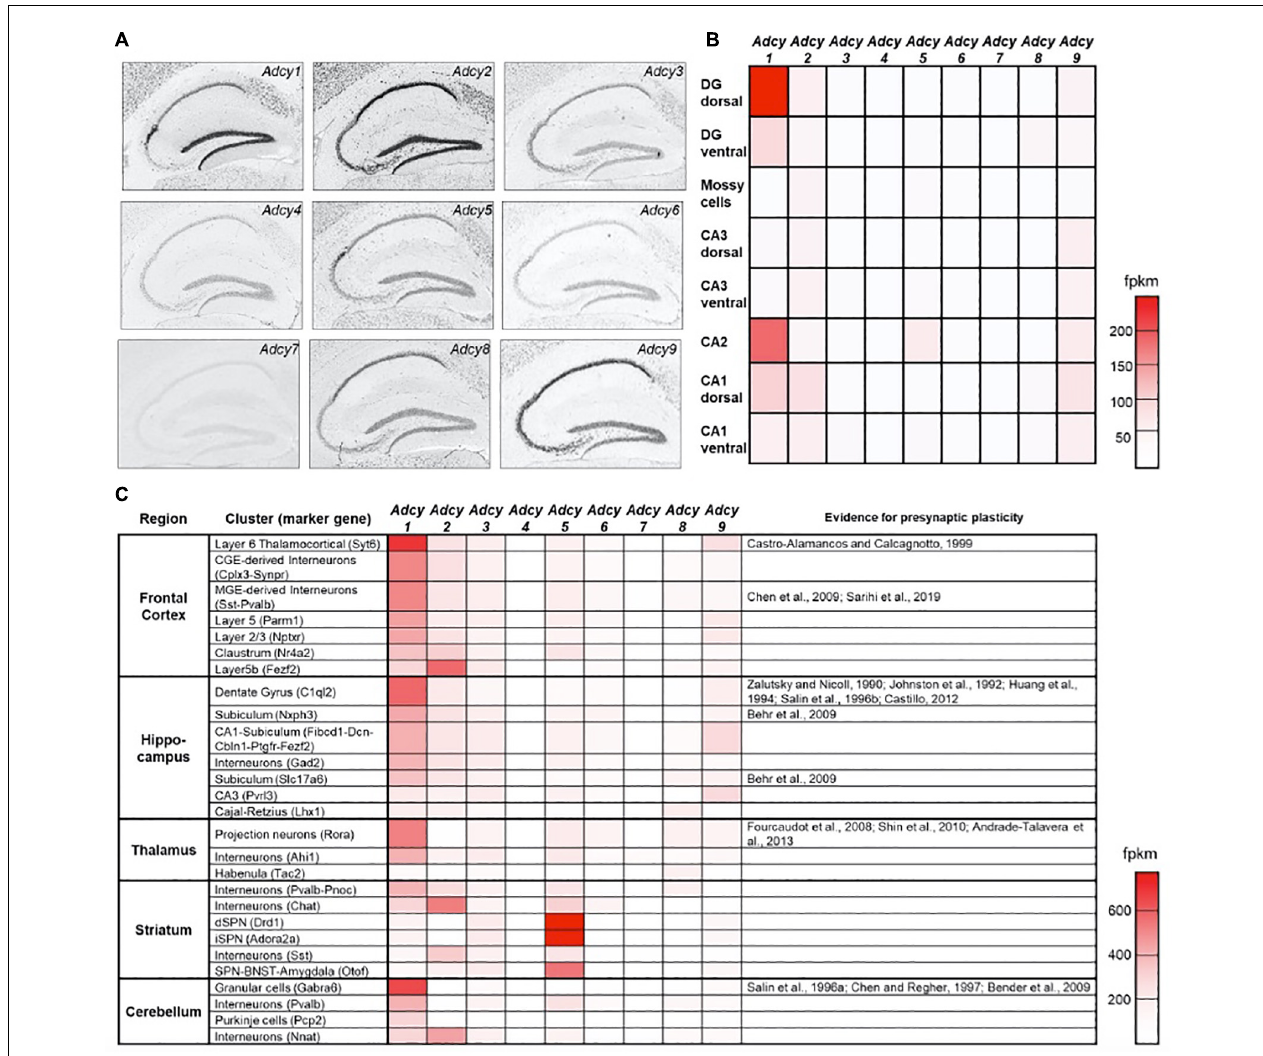
FIGURE 2 | Expression of AC isoforms across hippocampal sub-regions. (A) Distribution pattern of the ten AC isoforms in the hippocampus of adult mice following in situ hybridization (Lein et al., 2007). (B) A heat map showing the relative mRNA expression levels of Adcy isoforms 1–9 across different hippocampal sub-regions. fpkm—fragments per kilobase of transcript per million mapped reads (Cembrowski et al., 2016). (C) as in (B) , a heat map showing relative Adcy isoform 1–9 mRNA expression levels for the main cell clusters across several central brain regions. The right-most column specifies for which cell clusters evidence supports the existence of presynaptic LTP (Saunders et al., 2018). Data in (A) were adapted from the Allen institutes ISH brain atlas (http://mouse.brain-map.org/), data in (B) were adapted from hipposeq.janelia.org/and data in (C) were adapted from Dropviz.org.